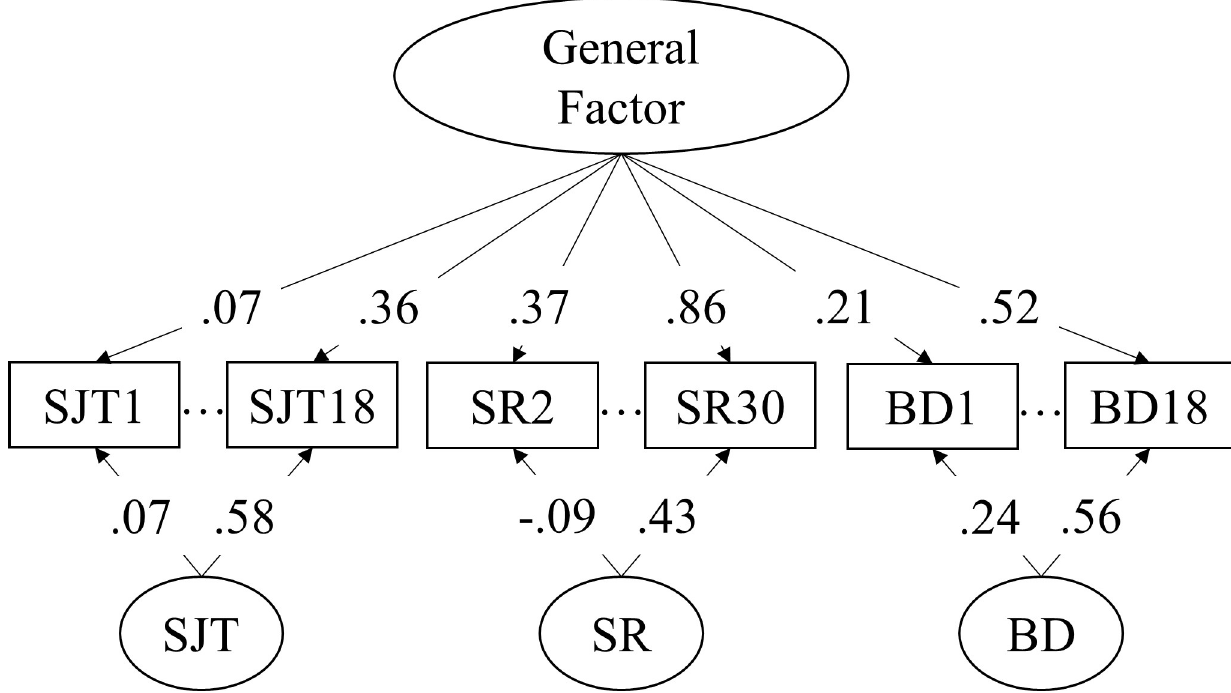
Fig 1. Multi-method bi-factor model of dependability. SR = self-report; BD = biodata. The loadings presented represent the standardized loading range of the corresponding scales. Negative loadings on the SR and BD factors result from response effects (e.g., acquiescence) on negatively coded items. Model fit: CFI = .90; RMSEA = .04; SRMR =